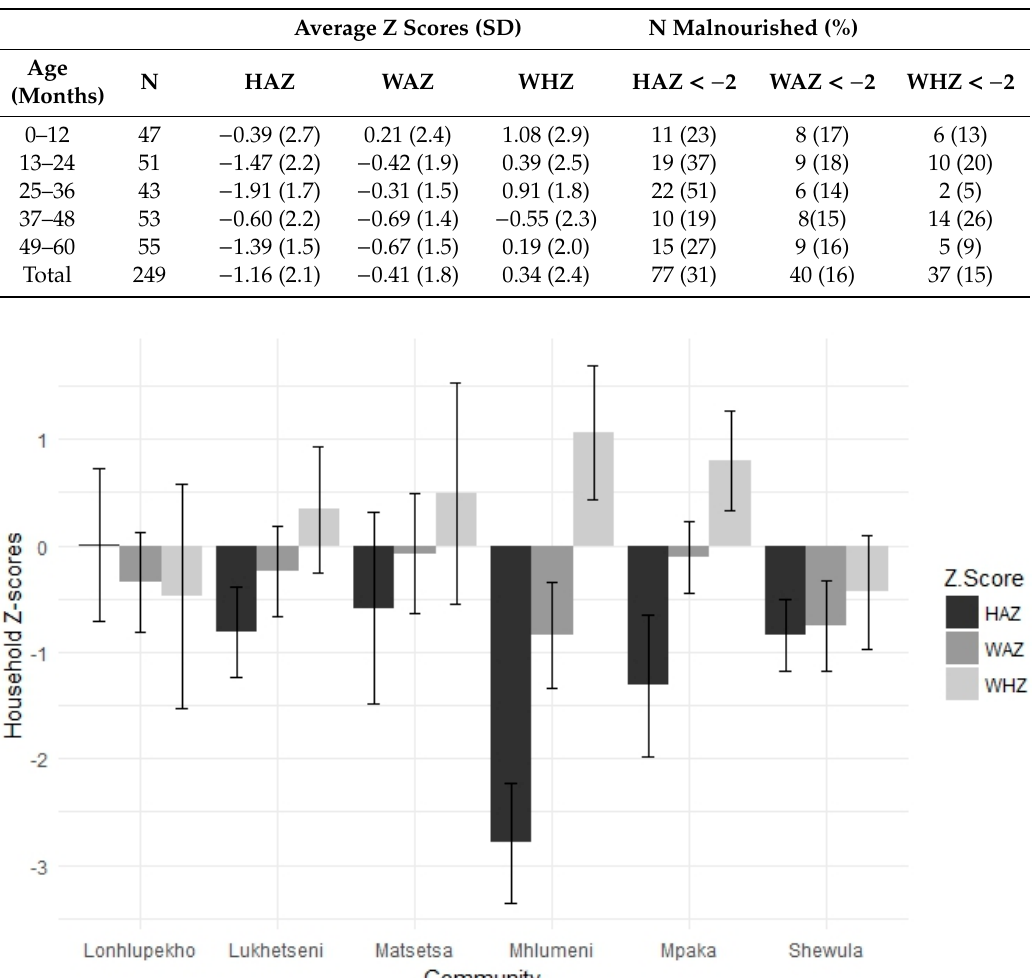
Table 1. Summary of household z-scores for children under five in households in the Lubombo region of Eswatini and proportion of children with z-scores below − 2.